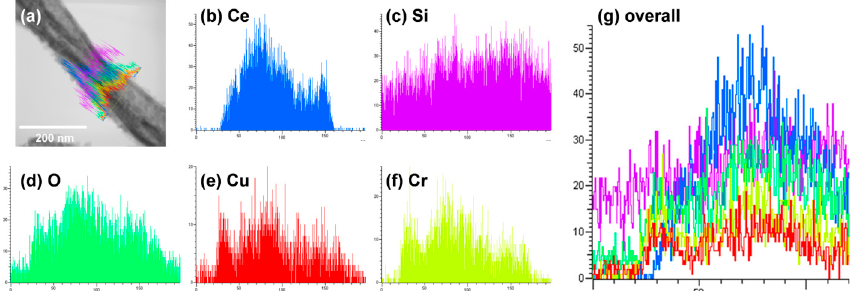
Figure 8. STEM image of CeO 2 -CuCrO 2 nanofibers. ( a ) Overall STEM spectrum of Ce, O, Si, Cu, and Cr overlap; Elemental mapping of ( b ) Ce, ( c ) Si, ( d ) O, ( e ) Cu, ( f ) Cr. ( g ) Overall STEM-EDX spectrum of Ce, O, Si, Cu, and Cr overlap.